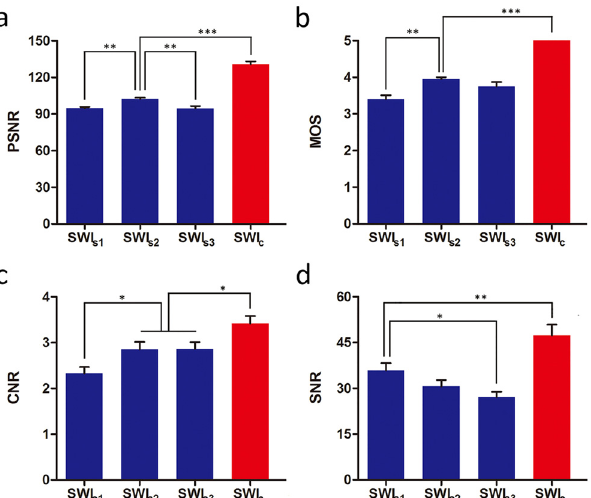
Fig 2. Comparisons of peak signal-to-noise ratio (PSNR), mean opinion score (MOS), contrast-to- noise ratio (CNR) and signal-to-noise ratio (SNR) between three different echoes of single-echo susceptibility weighted imaging (SWI s ) images (blue histogram, SWI s1 represented TE = 23.144 ms, SWI s2 represented TE = 29.192 ms, SWI s3 represented TE = 35.240 ms) and combined multi-echo SWI images (red histogram, SWI c represented combined multi-echo SWI). Note. *** indicated P < 0.001; ** indicated P < 0.01; * indicated P < 0.05. Horizontal line represented the two groups had the same value when rounding to one decimal.